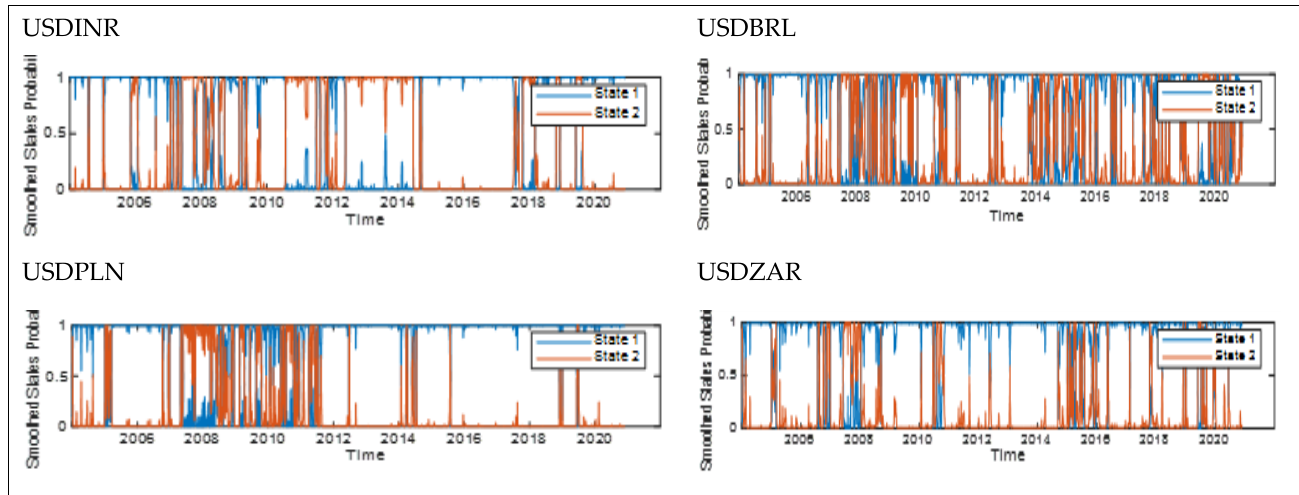
Figure 1. The smoothed regimes (state 1 and state 2) evolved over time for the US foreign exchange on domestic currencies of Brazil, India, Poland, and SA.